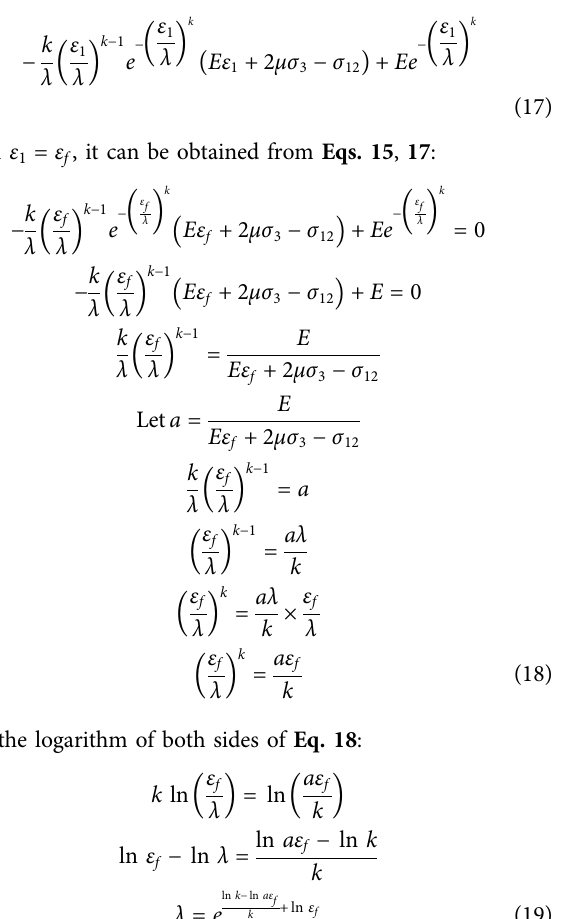
Frontiers in Materials |